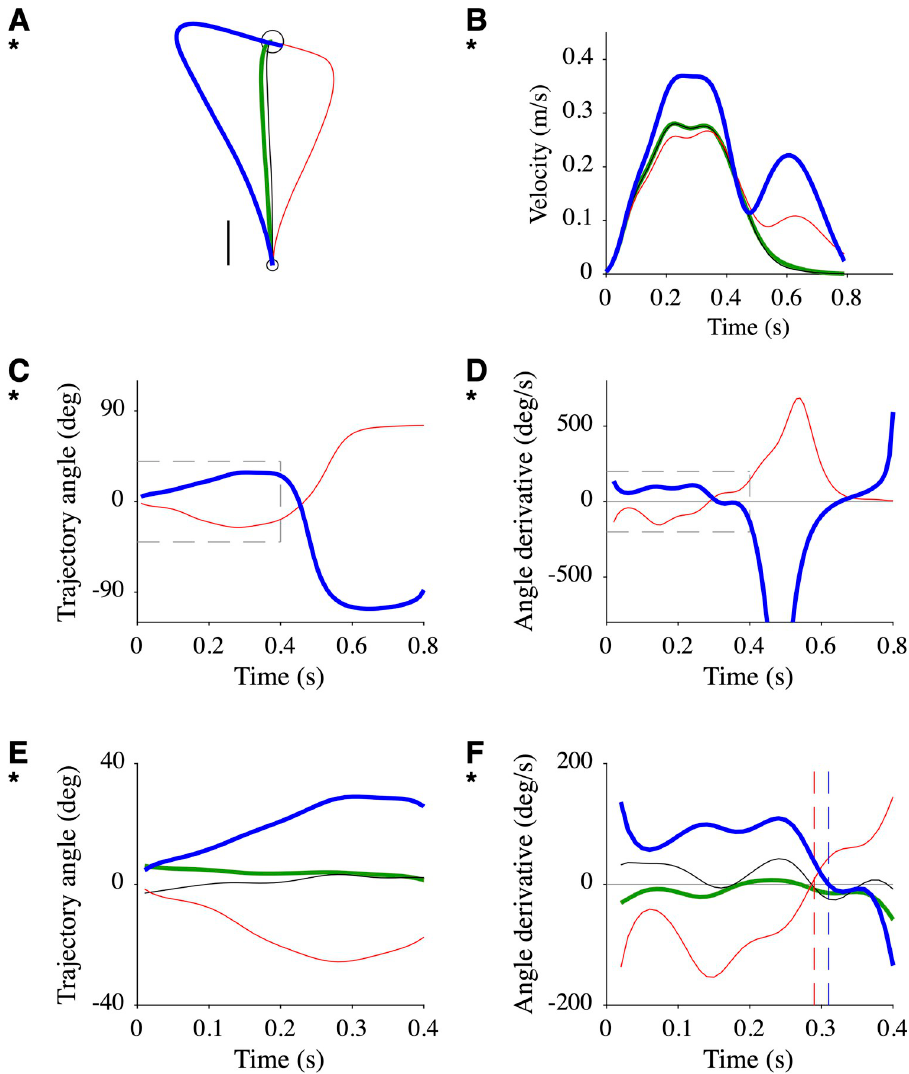
Fig 4. Model predictions. A . Simulated adapted ( green ) and after-effect ( blue ) trajectories corresponding to simulated baseline ( black ) and before-effect ( red ) trajectories shown in Fig 3D and reproduced here with thin lines . Scale: 0.02 m. B . Simulated velocity profiles. C . Trajectory angle for A . D . Trajectory angle derivative for A . E . Zoom on trajectory angle ( dotted box in C ). F . Zoom on trajectory angle derivative ( dotted box in D ). Vertical dashed lines indicate the time of change in derivative